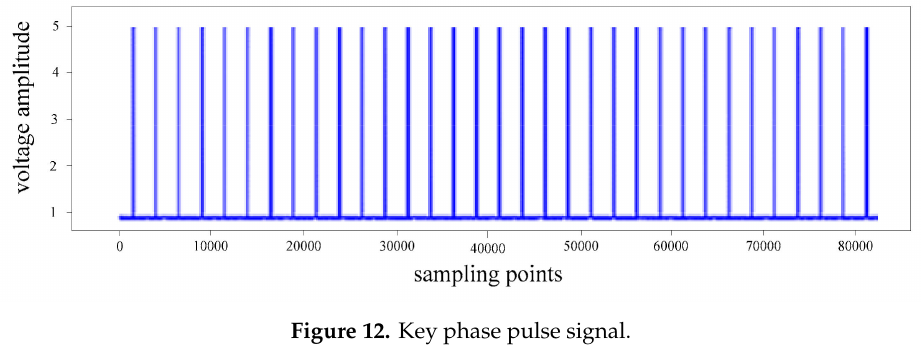
Figure 12. Key phase pulse signal.